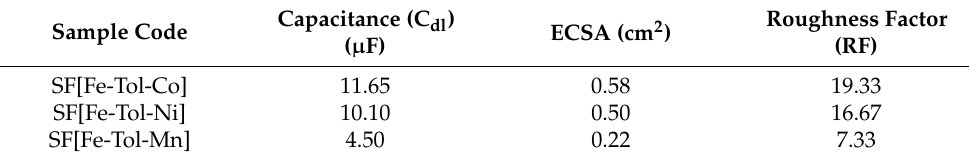
Table 1. C dl , ECSA, and RF values for